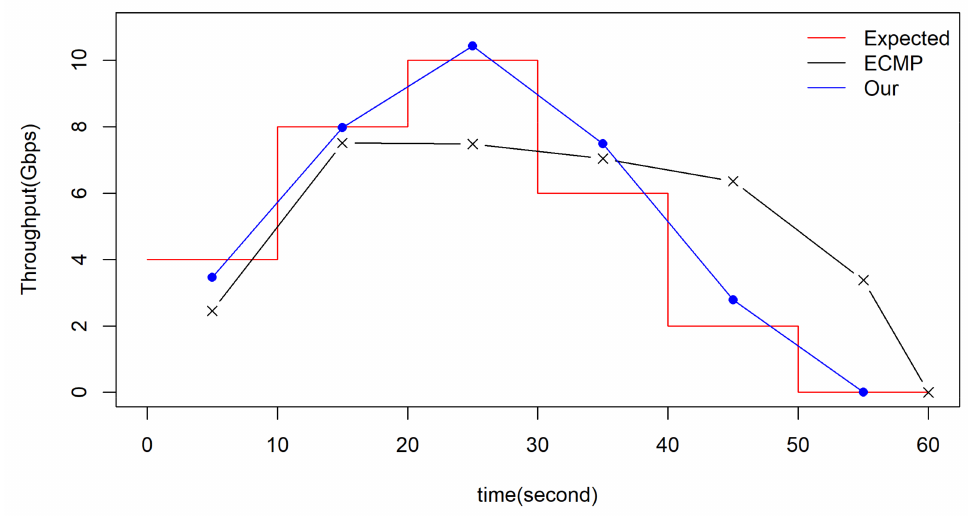
Figure 7. Results of the selection